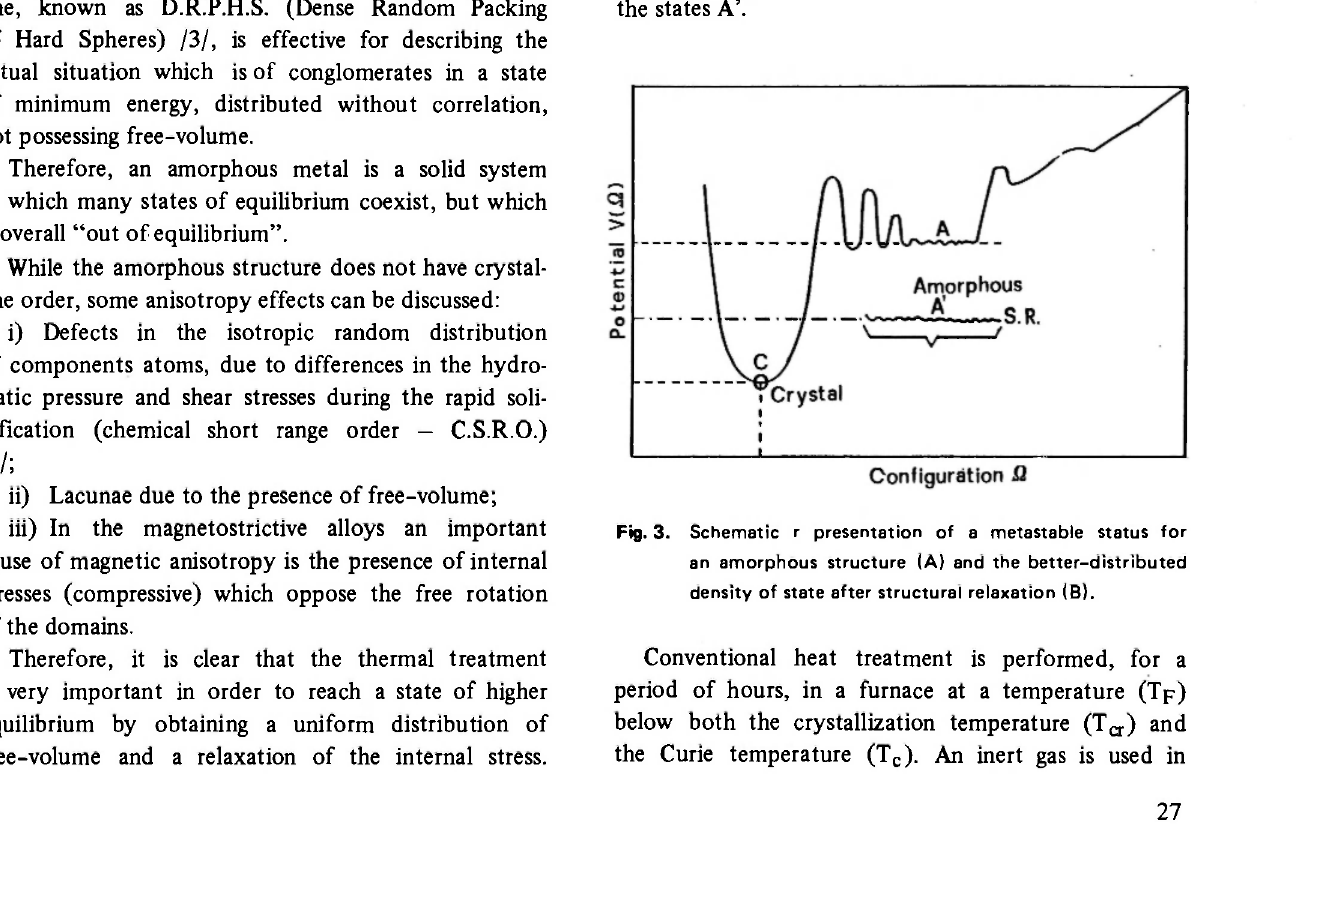
Fig. 3. Schematic r presentation of a metastable status for an amorphous structure (A) and the better-distributed density of state after structural relaxation